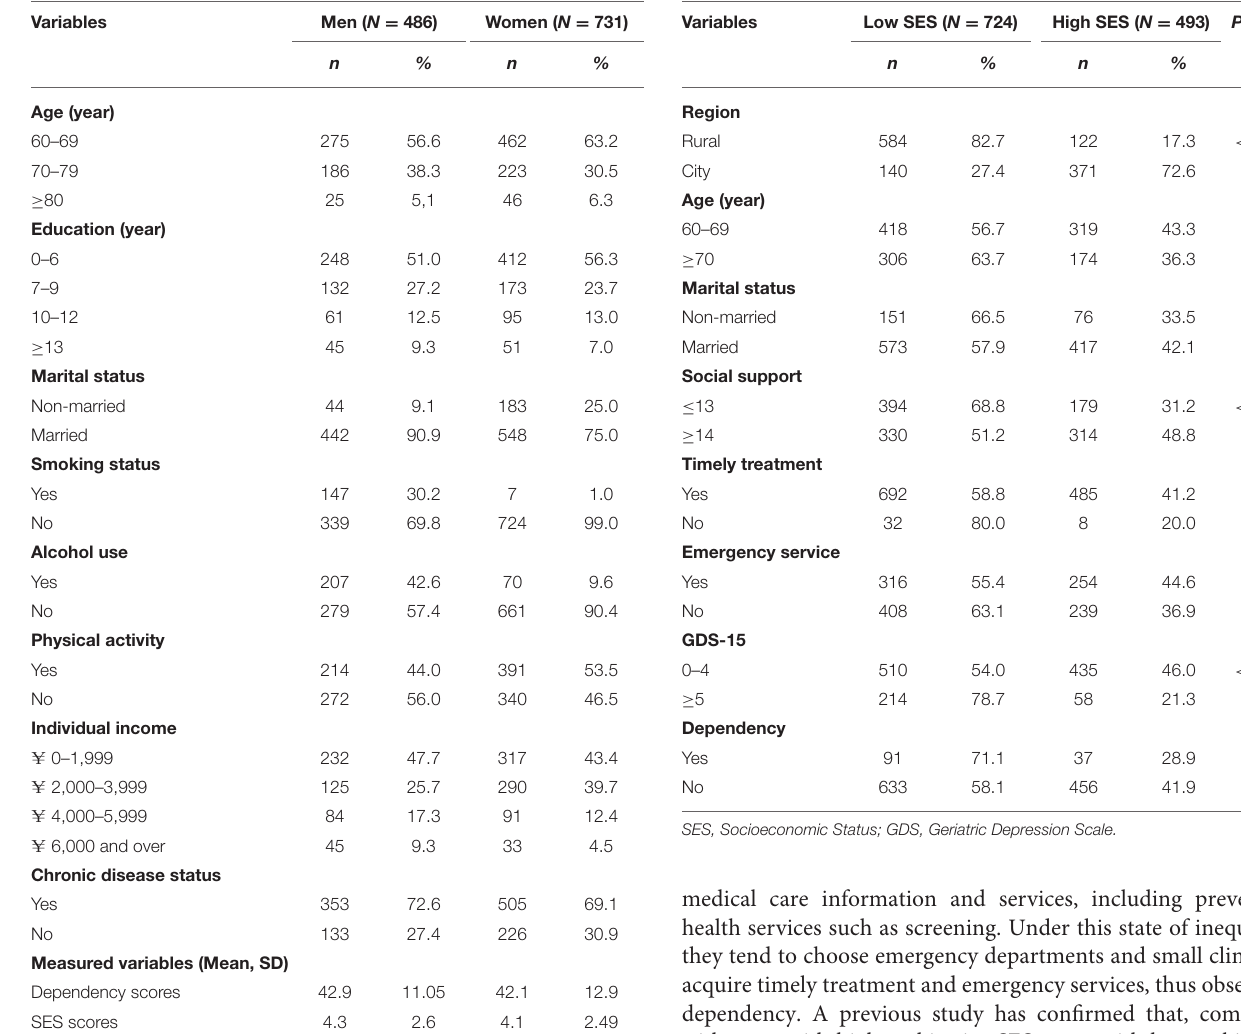
TABLE 2 | The level of socioeconomic for characteristics of participants in chi-squared